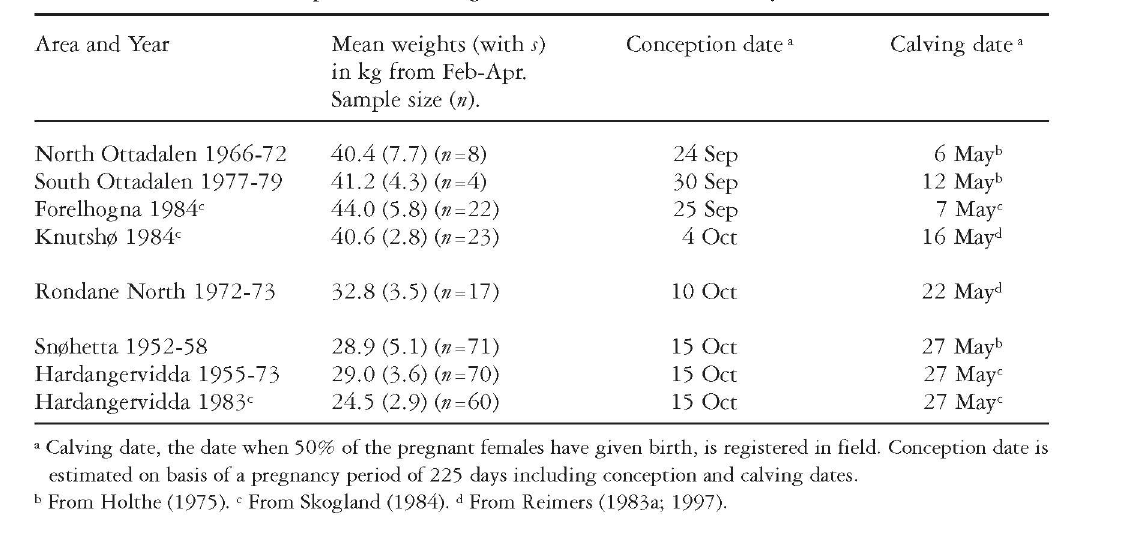
Table 1. Dressed weights from pregnant females 1 yr + sampled from Nov through May and calving time and estimated conception date among wild reindeer herds in Norway. s = standard deviation.